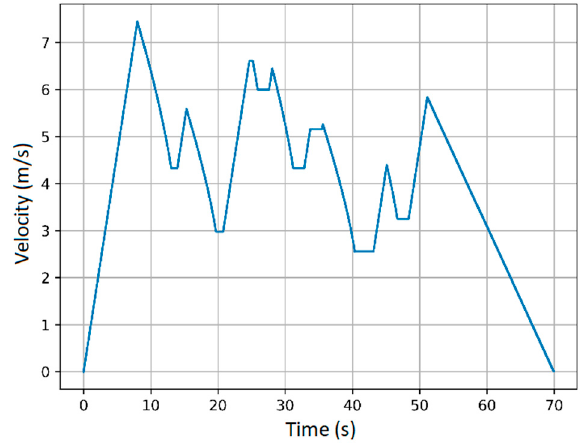
Figure 12. An example of a velocity profile obtained by proposed velocity profile generator.